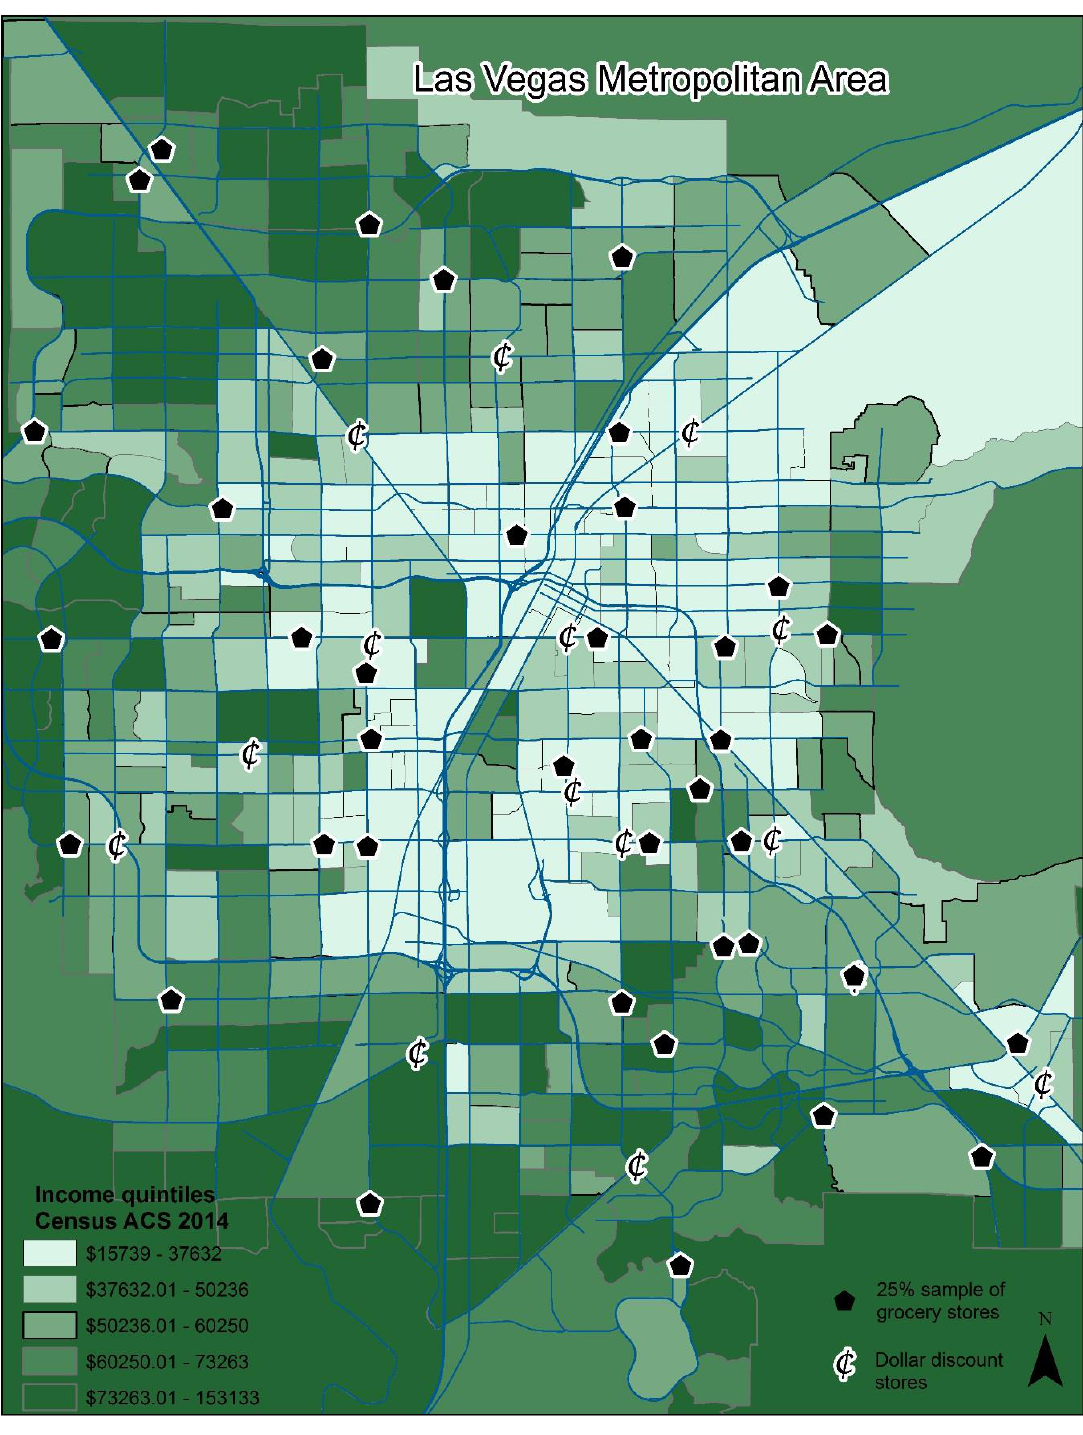
Figure 1. Map depicting the dollar discount stores audited ( n = 14) and grocery stores audited ( n = 40) representing a 25% sample of all grocery stores. Income quintiles based on Clark County, NV median household income per the 2014 U.S. Census, American Community Survey (ACS) five-year estimates.